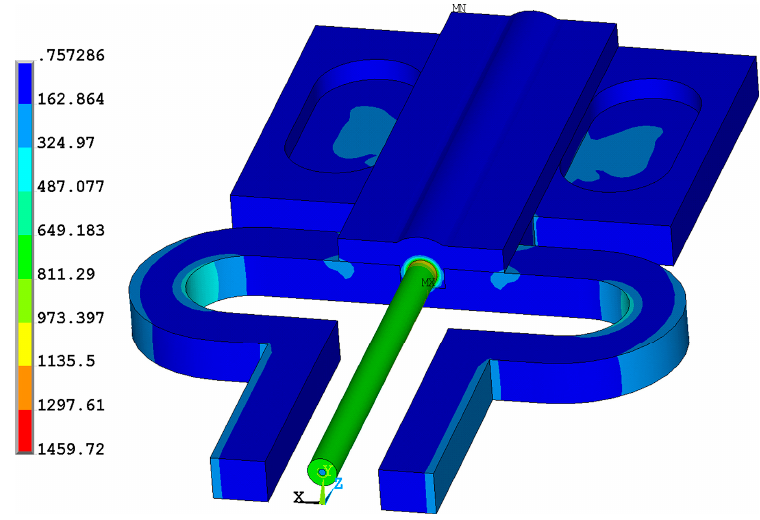
Figure 12. Von Mises stress distribution in the metal-packaged RFBG strain sensor at a strain of 0.26% applied to the test specimen at room temperature.